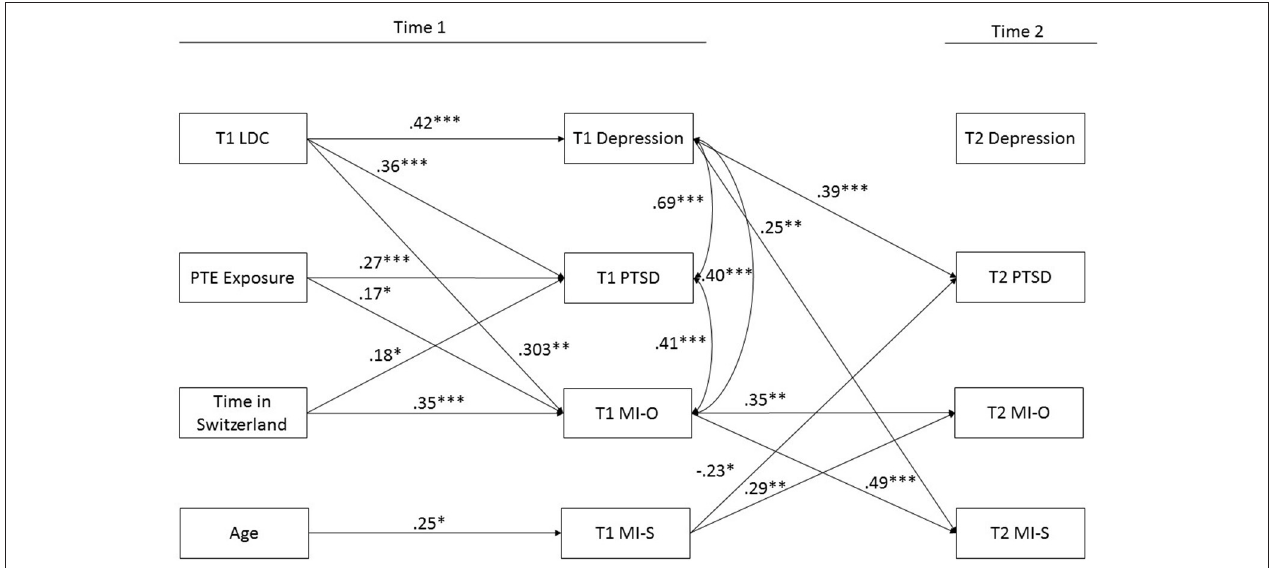
FIGURE 1 | Longitudinal association between refugee experiences, moral injury appraisals and psychological symptoms in traumatized refugees. LDC, Postmigration living difficulties; PTE, Potentially Traumatic Events; T1, Time 1; T2, Time 2; MI-O, Moral injury Other; MI- S, Moral Injury Self. * p < 0.05, ** p < 0.01, *** p < 0.001.